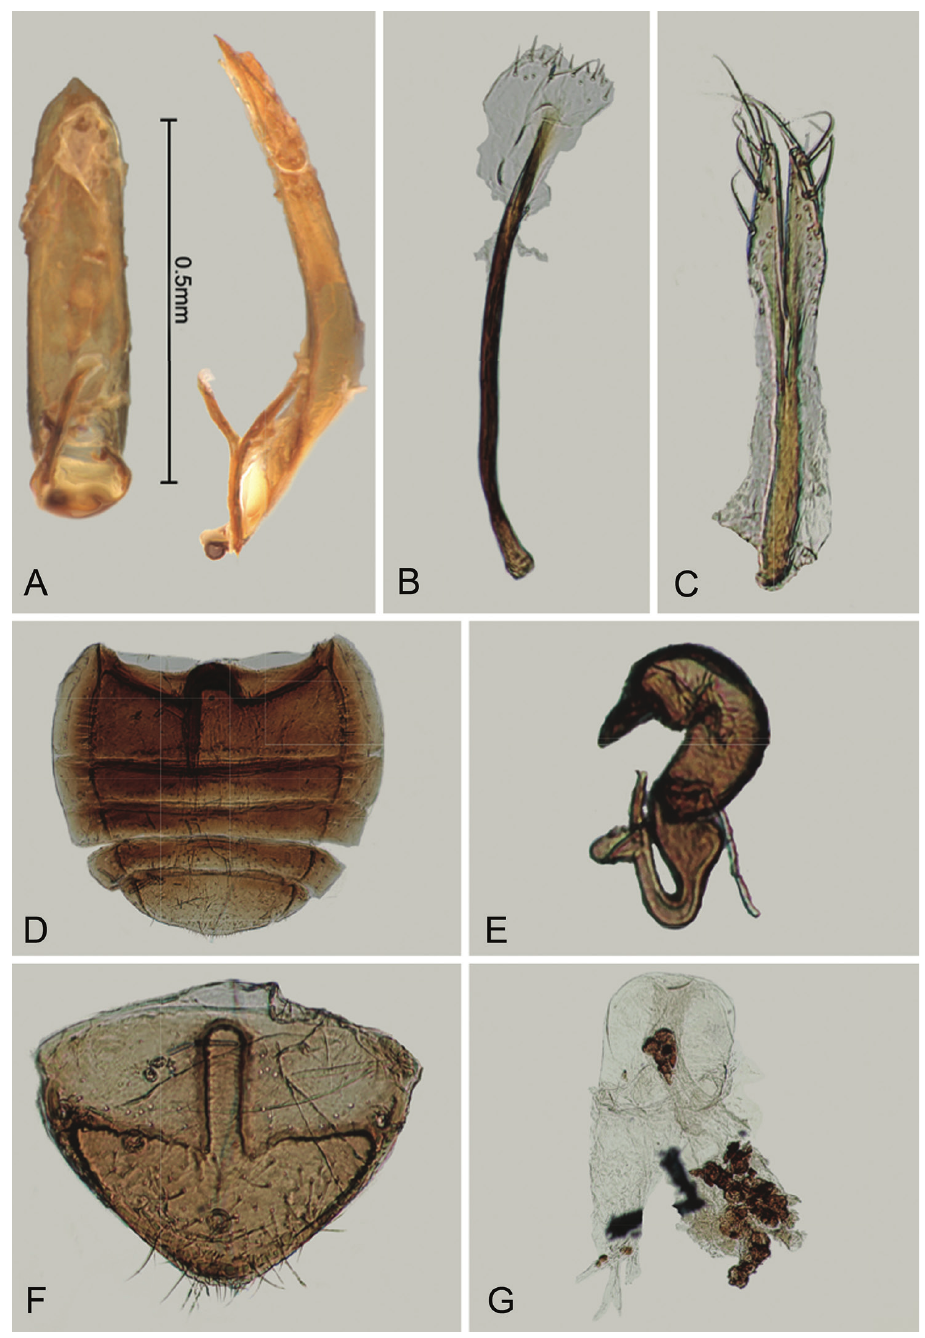
Figure 29. Andersonoplatus peck . A Median lobe of aedeagus, ventral and lateral views B Tignum C Vaginal palpi D Female abdomen, ventral view E Spermatheca F Last abdominal tergite of female G